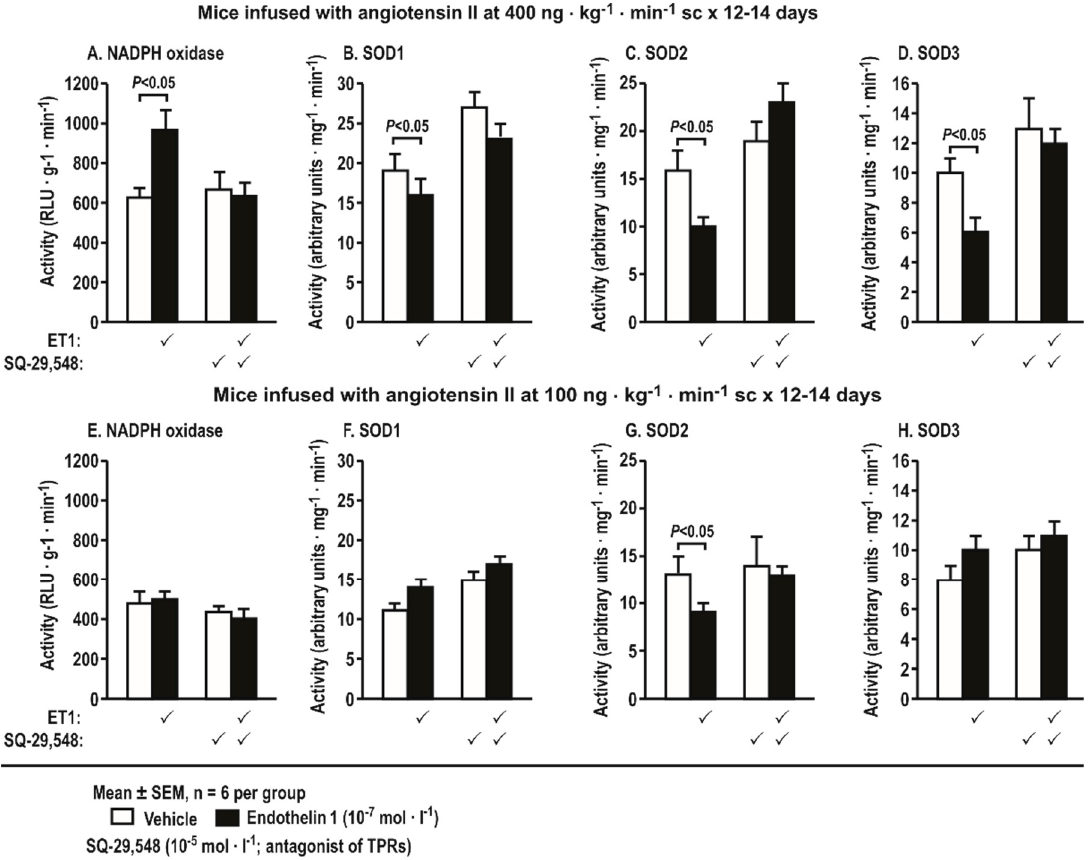
Figure 8. Incubation of aortas with endothelin 1 (10 − 7 mol · L − 1 × 4 h) from mice with angiotensin II infusion at a slow pressor rate of 400 ng · kg − 1 · min − 1 sc × 14 days increases the activity of nicotinamide